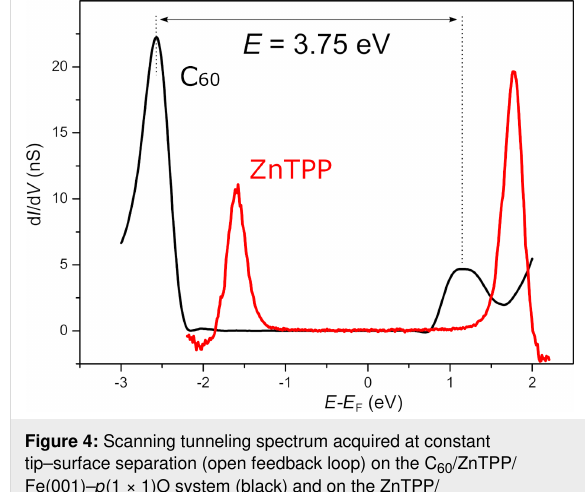
Figure 4: Scanning tunneling spectrum acquired at constant tip–surface separation (open feedback loop) on the C 60 /ZnTPP/ Fe(001)– p (1 × 1)O system (black) and on the ZnTPP/ Fe(001)– p (1 × 1)O surface (red). The black curves have been ob- tained by averaging 30 single spectra taken on equivalent C 60 domains. The set point before the acquisition of the spectra was set to V = 1.5 V and I = 1